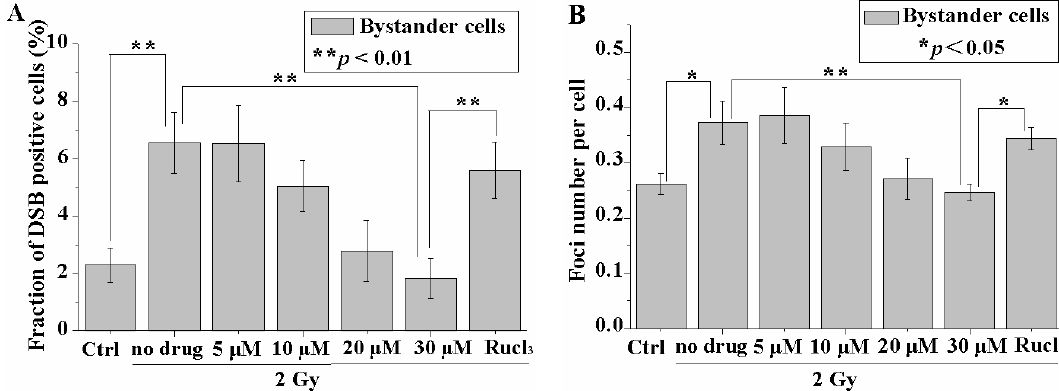
Figure 2. CO decreases double-strand breaks (DSBs) in bystander cells. Fraction of p53BP1-positive cells ( A ); and foci number per cell ( B ) in the bystander cells with or without CO (tricarbonyldichlororuthenium, CORM-2) treatment. Data are pooled from at least three independent repeats and the results are presented as mean ± SD. Significances in the differences between the samples are determined and differences with p < 0.05 are considered statistically significant. (* p < 0.05; ** p < 0.01).